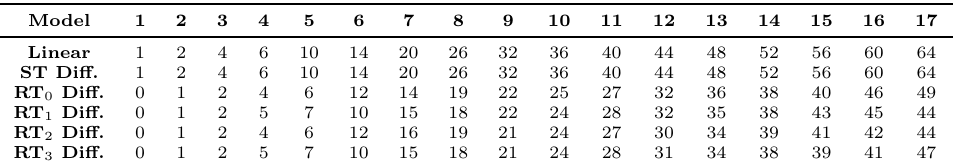
Table 5: Lower bounds on the minimum number of active Sboxes up to 17 rounds. RT i refers to the characteristic starting with round R 4 j + i